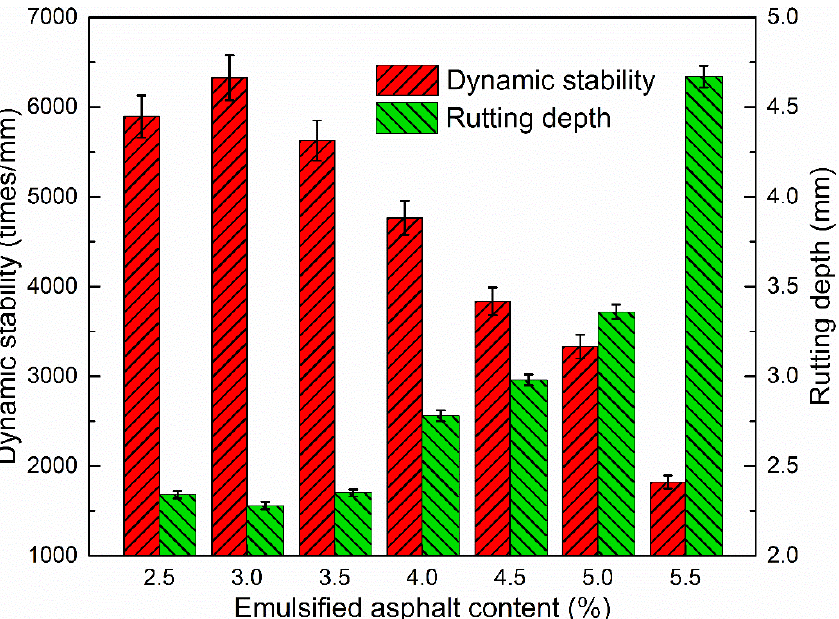
Figure 10. Influence of emulsified asphalt content on dynamic stability and rutting depth.